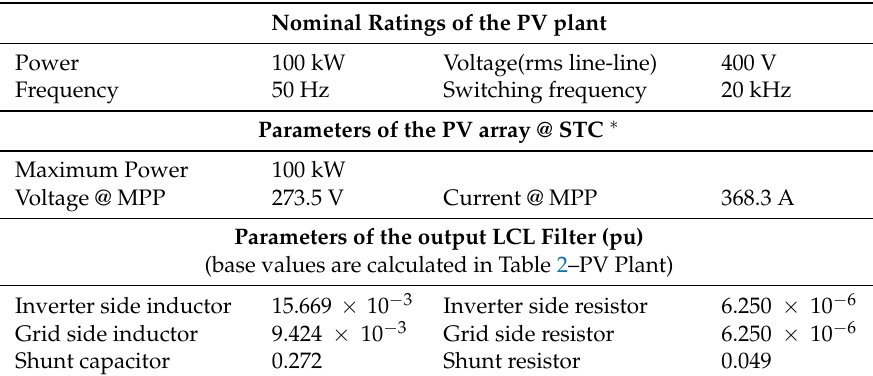
Table 6. Parameters of the PV plant in the